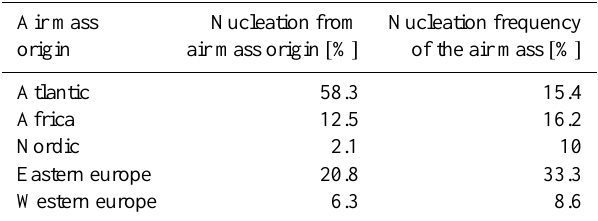
Table 2. New particle formation events according to air mass